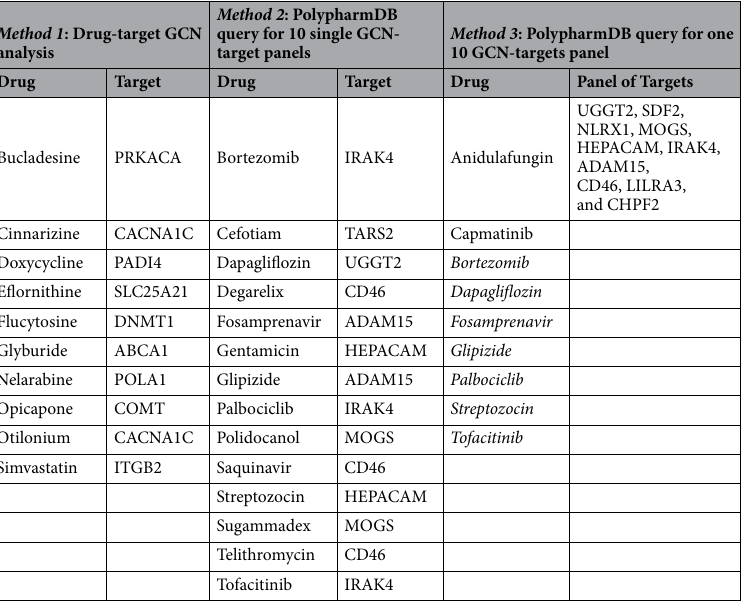
Table 1. Drugs that were selected for testing using three methods based on GCN analysis and MatchMaker predictions. Top 26 drug candidates were selected based on GCN and MatchMaker predictions as described in Fig. 1 and in Materials and Methods. Cefotiam, under Method 2, was selected from the list of 10 top ranking candidates for TARS2, which was among the top 100 human proteins predicted to be associated with COVID- 19 through target-only GCN analysis, but was not prioritized in the initial selection of top 10 targets described above. Drug candidates that were selected using Method 3 and were also predicted by Method 2 are shown in grey font and